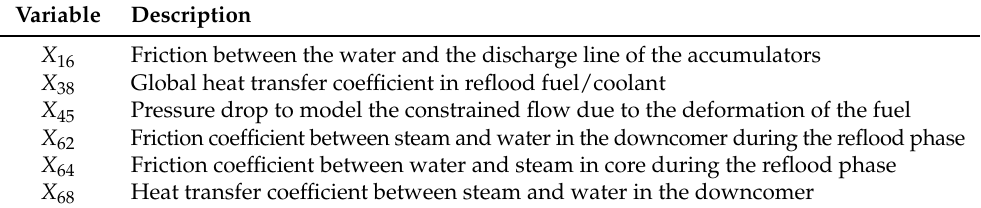
Table 4. Detected influential variables for θ ∈ M . The variables are not the actual values of the physical parameters, but multiplicative coefficients that increase of decrease their importance in a